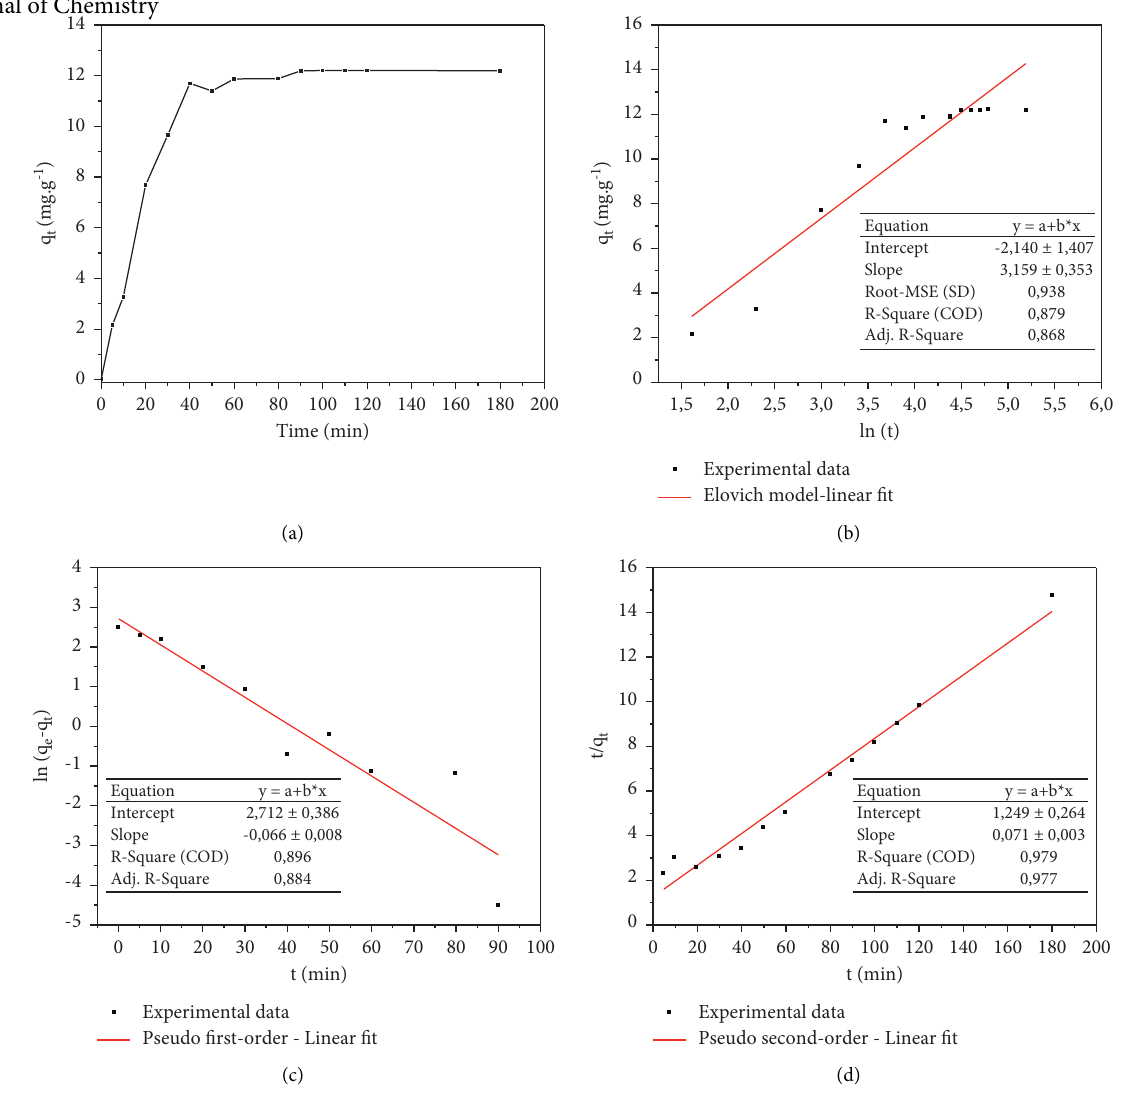
Figure 3: Kinetics of Cu(II) removal by SSP: (a) effect of time; (b) Elovich model; (c) pseudo-first-order model; (d) pseudo-second-order model (pH: 4.7; Cu(II) concentration: 100mg · L − 1 ; dose: 8 g · L − 1 ; agitation speed: 200rpm; particle size: 300 μ m; temperature: 25 ° Table 1: Parameters and correlation coefficients obtained from the analysis of adsorption kinetics by pseudo-first-order model, pseudo- second-order model, and Elovich equation.